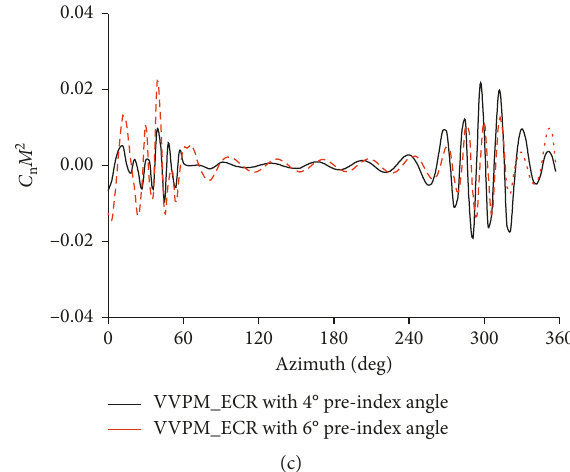
M 2 at 87% span location. n